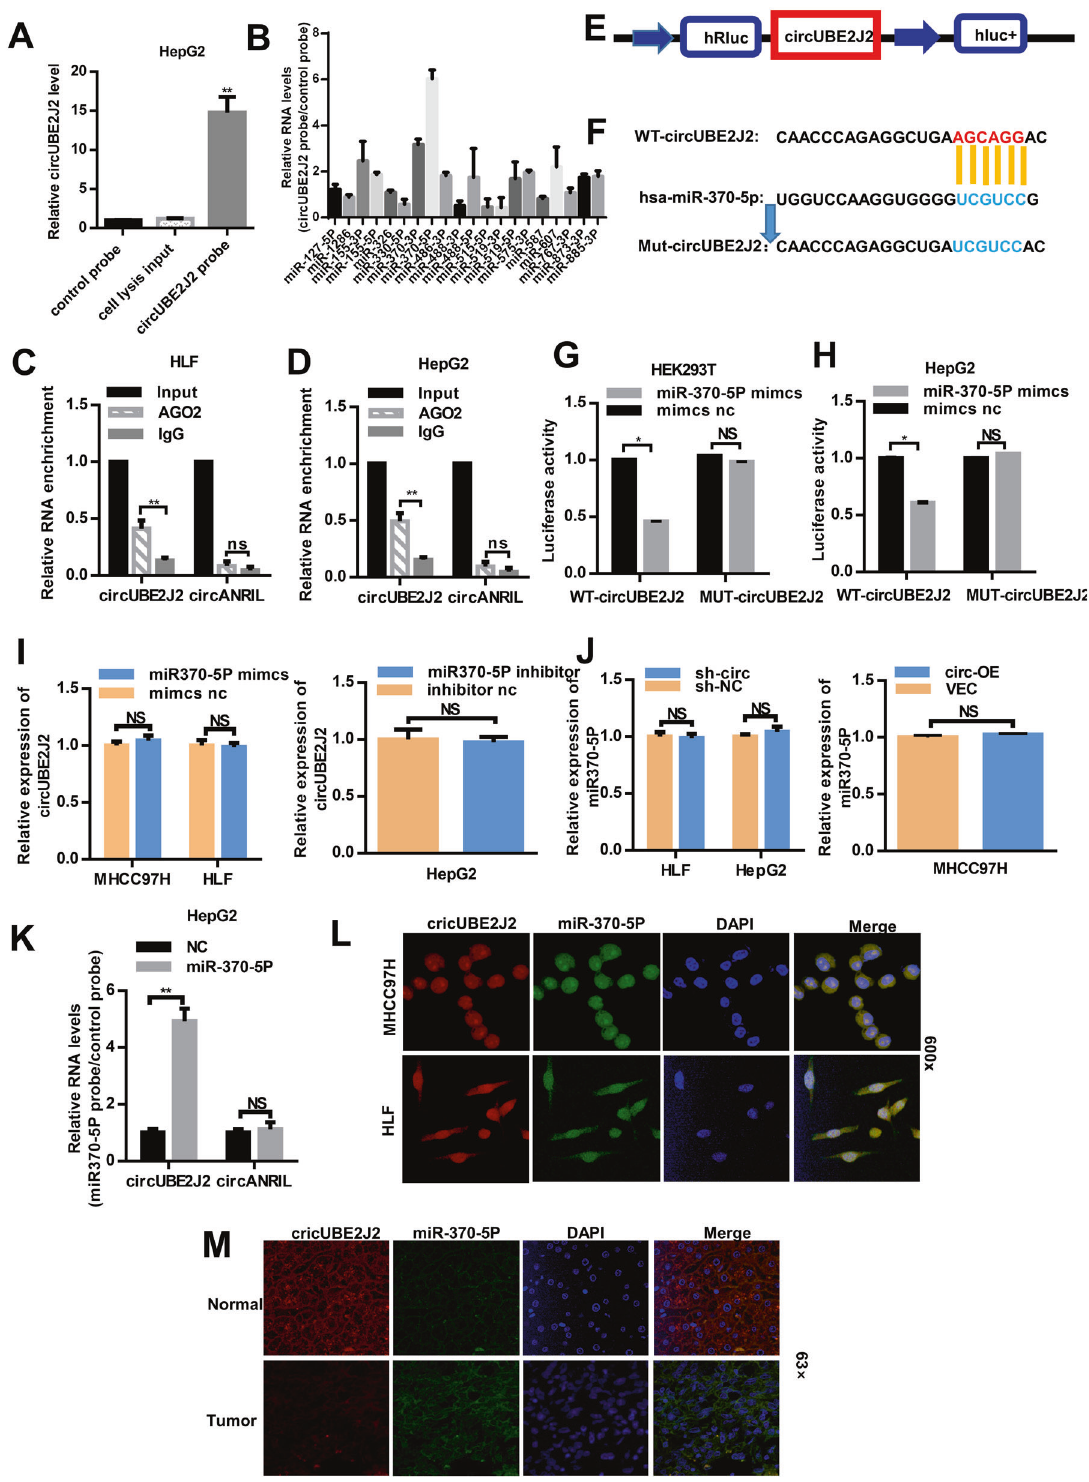
behaviors of HCC